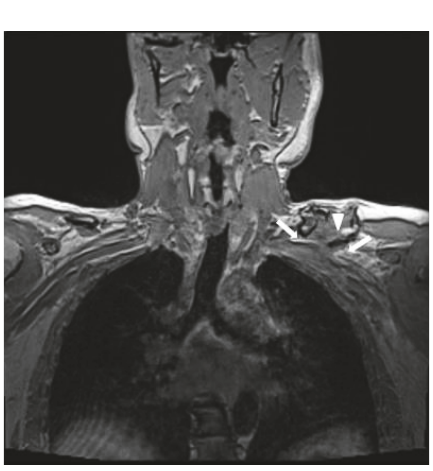
Figure 2: Coronal three-dimensional T1-weighted volumetric inter- polated breath-hold image shows compression of the infraclavicular part of the brachial plexus (white arrow) by an inferior bone fragment (white arrowhead).